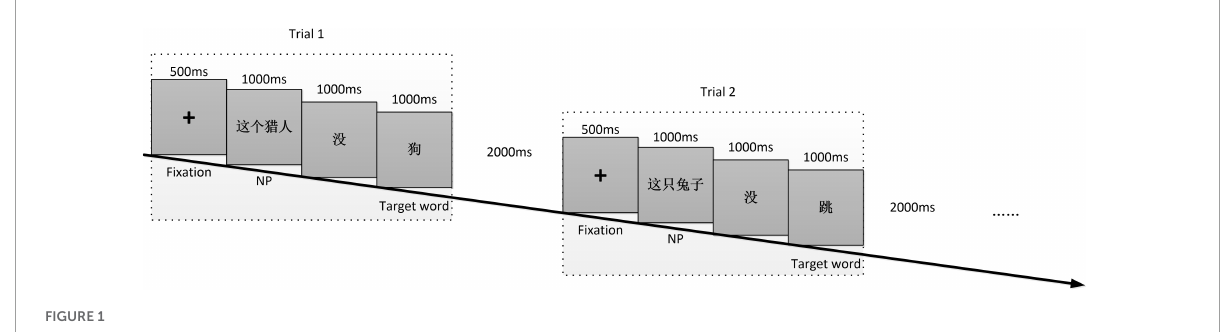
FIGURE1 The procedure of Exp.